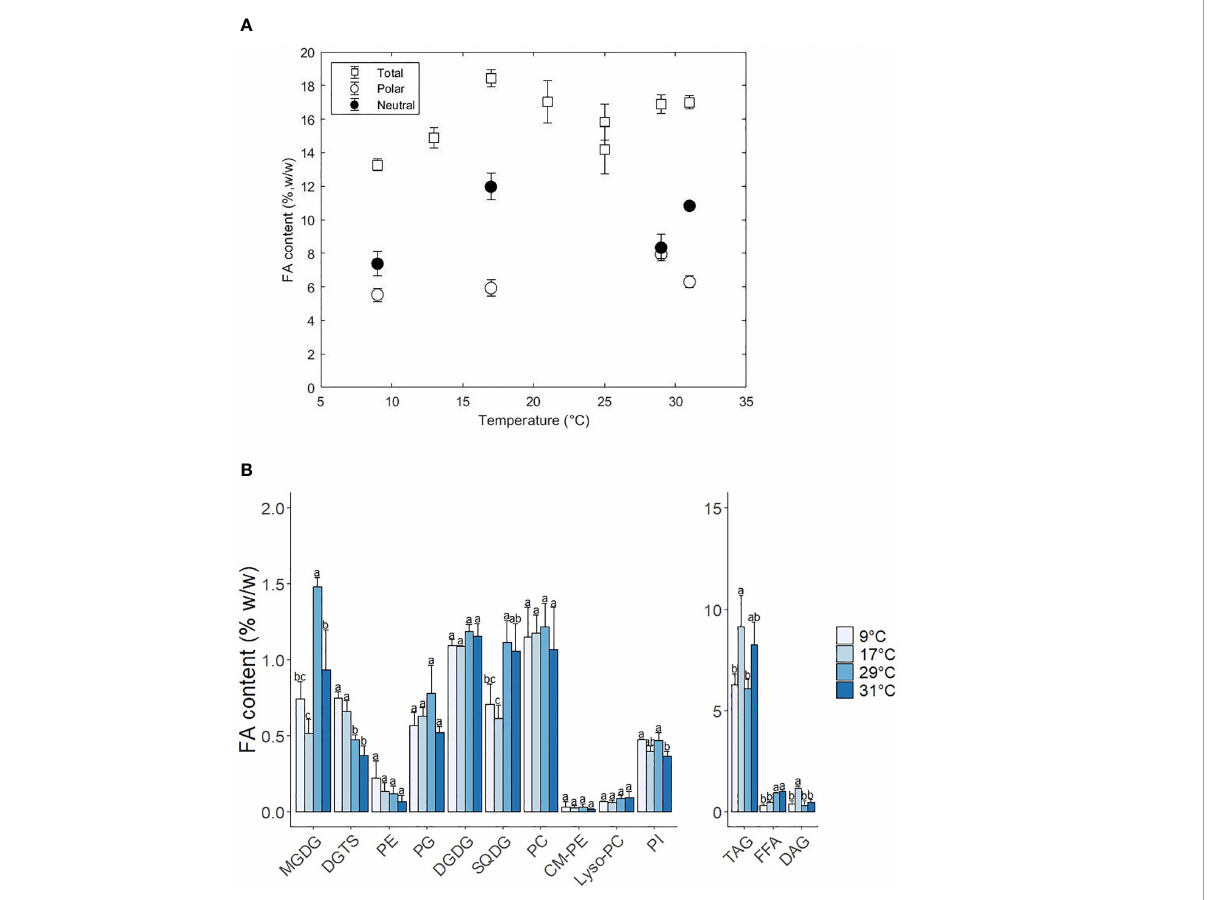
FIGURE 3 (A) Total fatty acid content (%, w/w) and distribution of fatty acids between polar and neutral fractions as a function of the temperature. (B) Change of lipid class content as a function of temperature. Standard errors indicate the standard deviation of 3 replicates. Letters a-c indicate statistically signi fi cant differences at P < 0.05 (Tukey